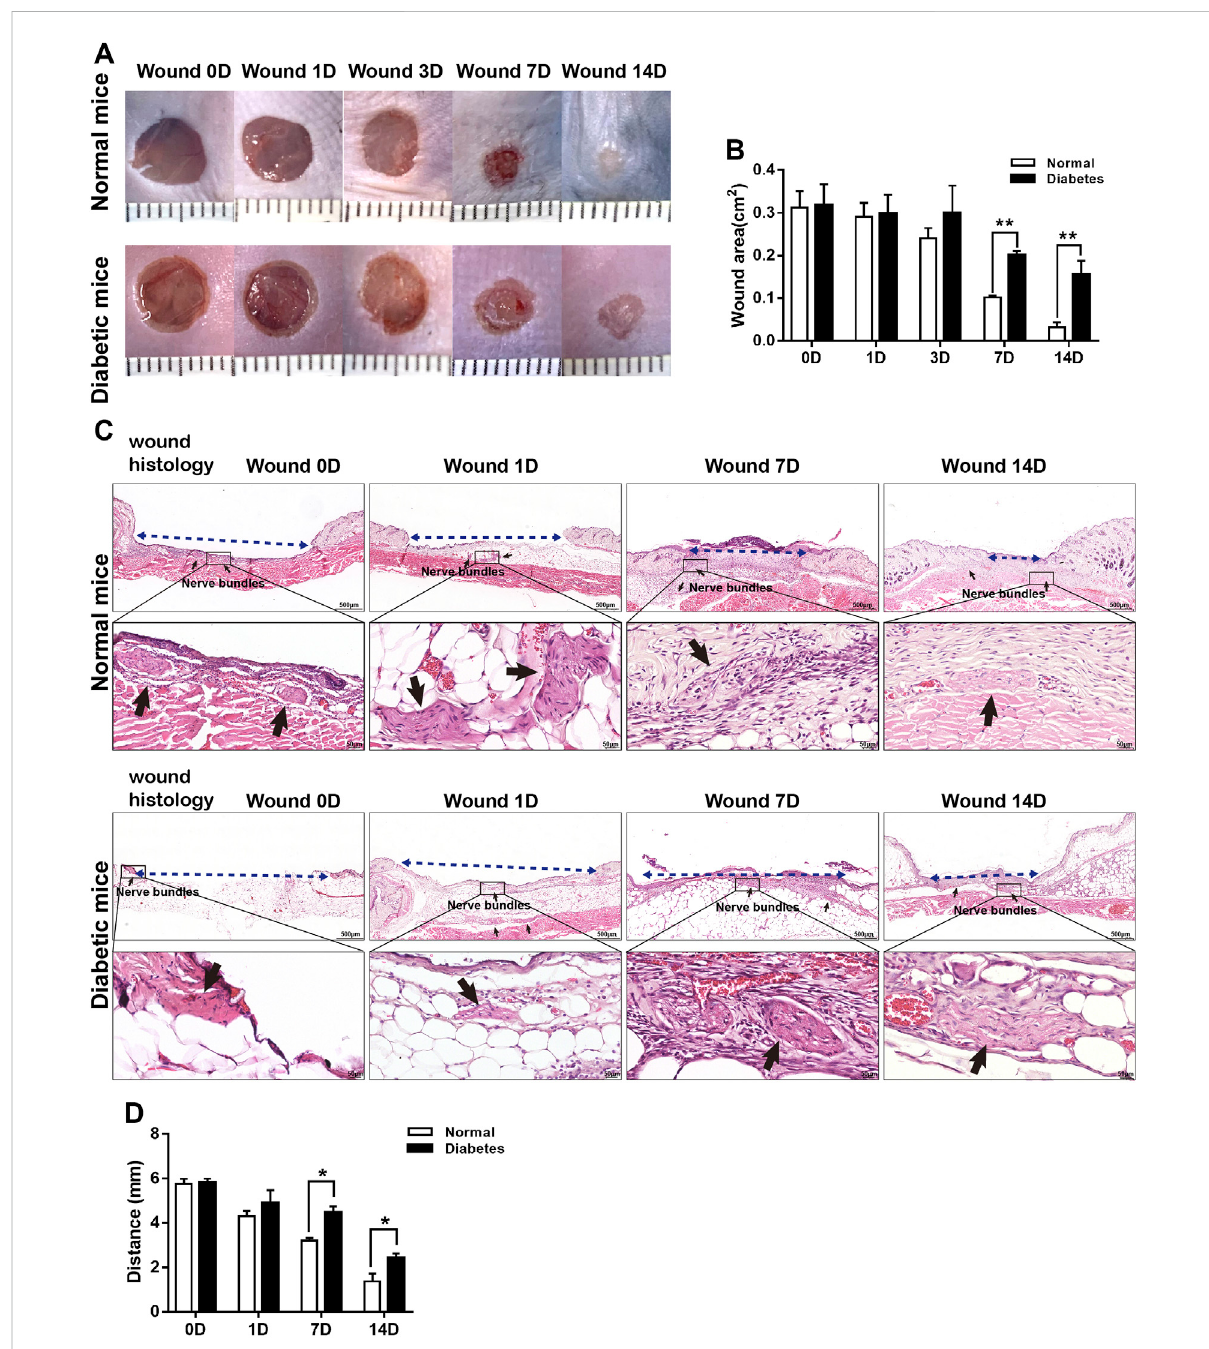
FIGURE 2 Diabetes delays cutaneous wound healing. (A) Representative macroscopic illustrations of normal and diabetic wounds on the backs of mice. (B) Measurementofthewoundareasatdays0,1,3,7,and14post-wounding. (C) H&E-stained sectionsofnormalanddiabeticwoundsatdays0,1,7, and 14 post-wounding. The bluedotted lines represent wound contraction (distance betweenthe wound border hair follicles), and the black arrows show the nerve bundles. (D) Measurement of wound contraction at days 1, 7, and 14 post-wounding. Data are presented as mean ± SD, ** p < .01 and* p < .05, n = 6/group, two-way ANOVA, Bonferroni ’ s post hoc